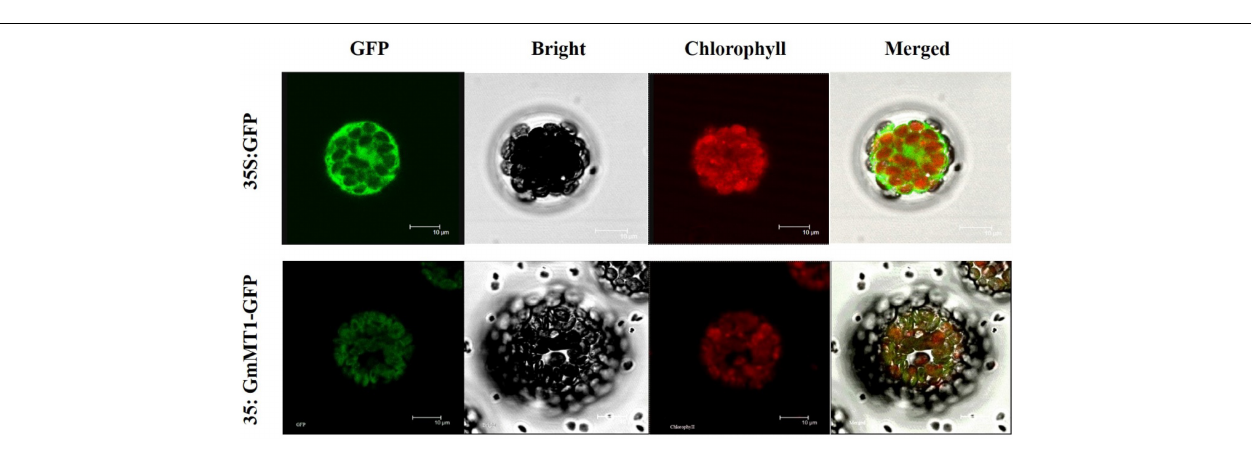
FIGURE 4 | Sub-cellular localization of the GmMT1 protein in Arabidopsis protoplasts. GmMT1-GFP expression was driven by the cauliflower mosaic virus 35S promoter and transiently expressed in Arabidopsis protoplasts. The images shown are GFP fluorescence (green) only, bright-field, chlorophyll auto-fluorescence (red) only, and combined. Scale bars = 10 µ